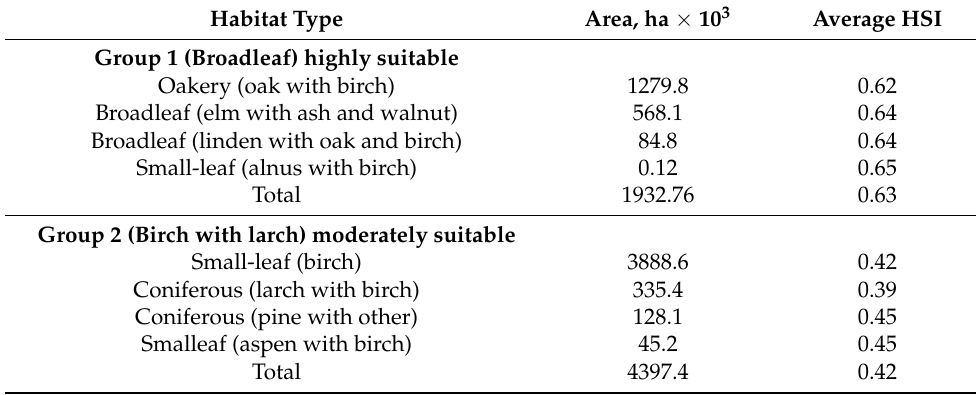
Table 8. Results of raster cross-tabulation of habitat types and habitat suitability